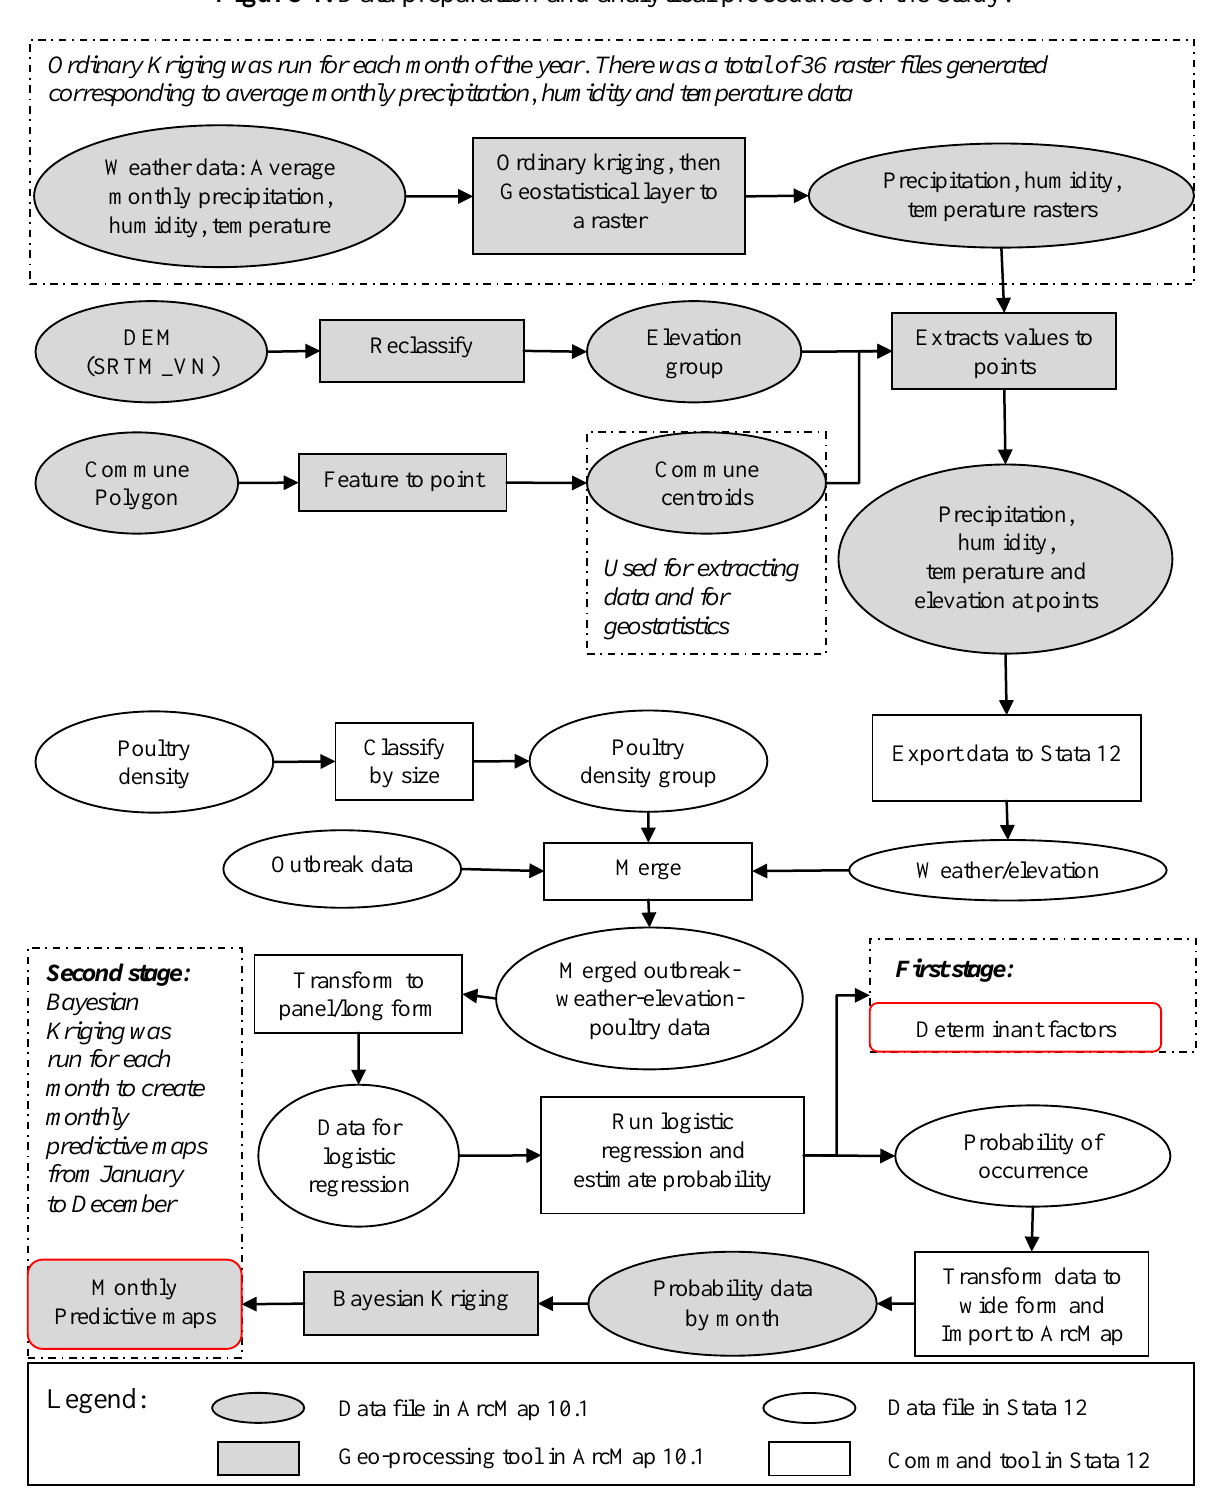
Figure 4. Data preparation and analytical procedures of the